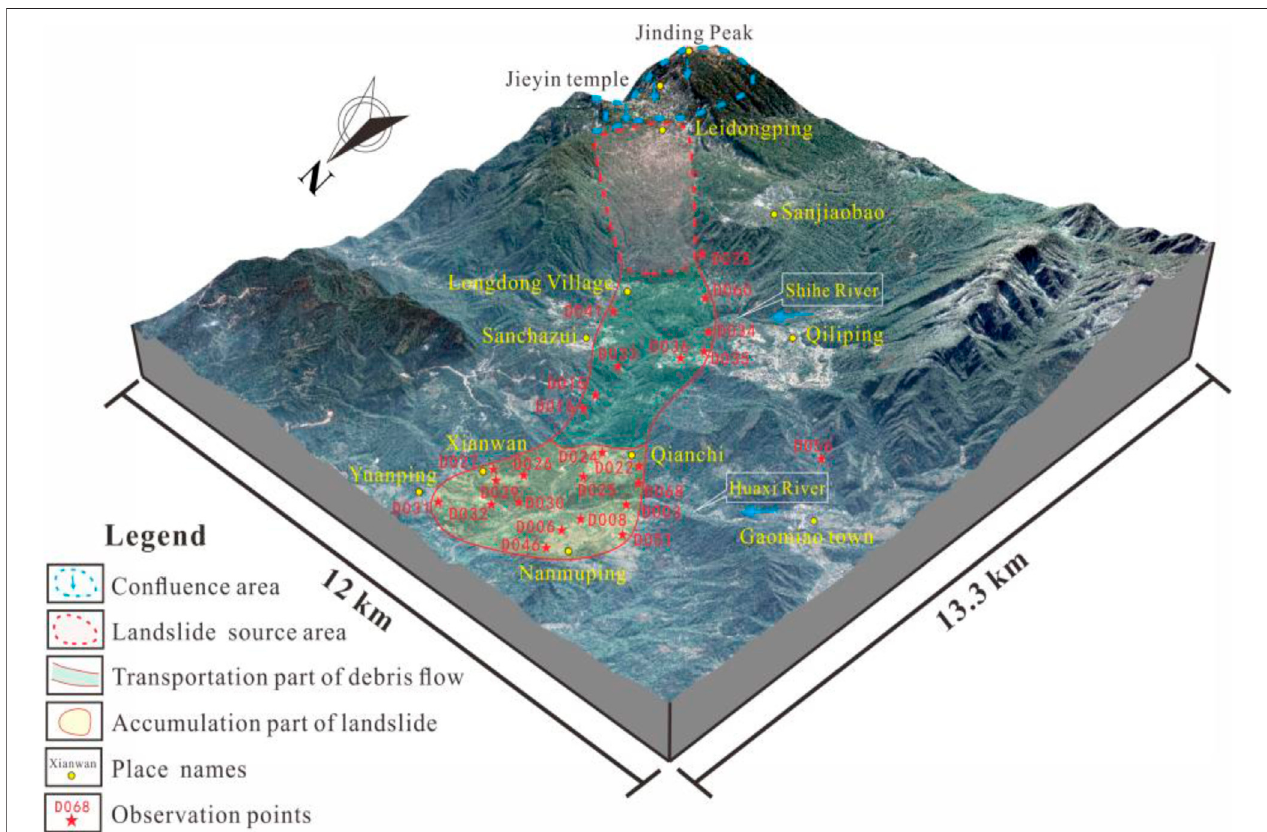
FIGURE 2 | Remote sensing image of the Jiaopenba paleolandslide (image from Google Earth).